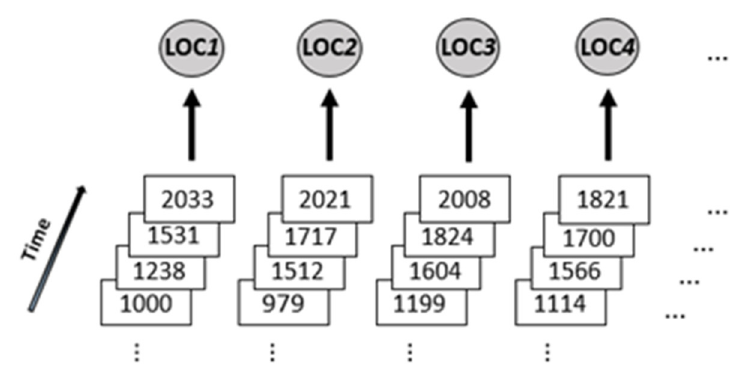
Figure3. Inputlayerrepresentation: Figure 3. Input layer representation: each neuron receives a series referring to a specific reference location.